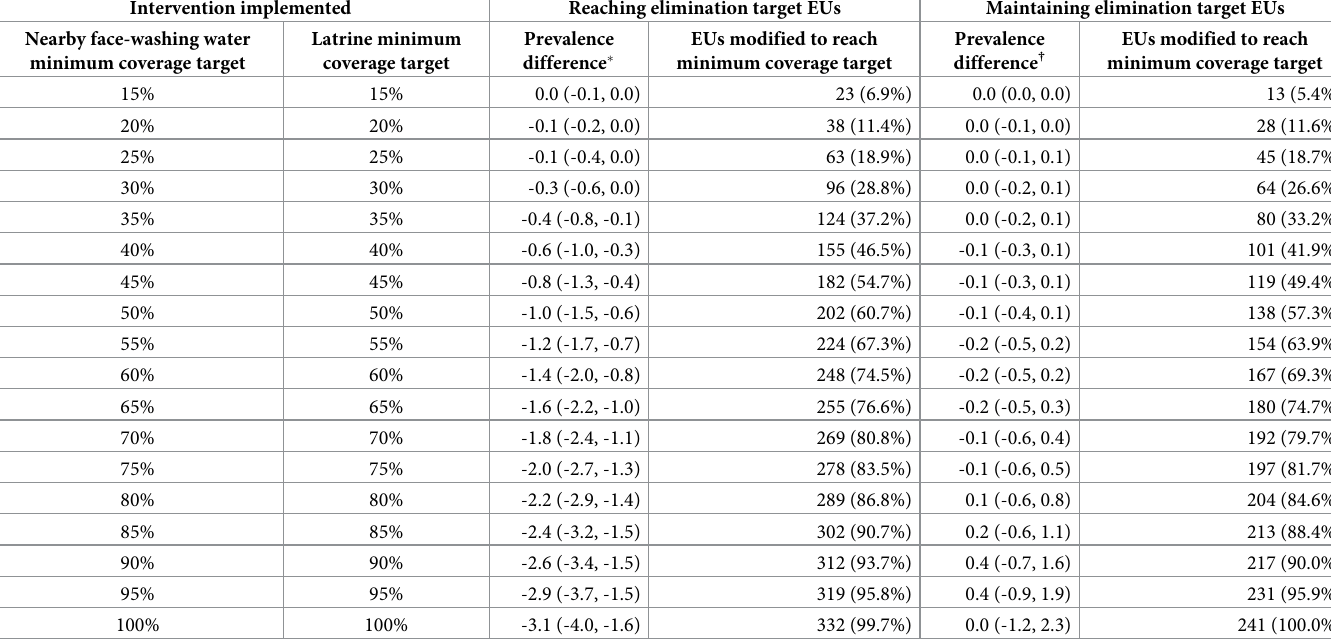
Figures shown in prevalence differences columns are the estimates and 95% confidence intervals. The prevalence difference is estimated as the mean predicted probability from the hypothetical intervention scenario minus the mean predicted probability from the observed data. Figures shown in the EUs modified columns are the count and percentage of EUs modified. EU: Evaluation Unit, TF 1-9 : trachomatous inflammation—follicular among children aged 1–9 years. � Model-derived TF 1-9 prevalence in the observed data was 4.7%.